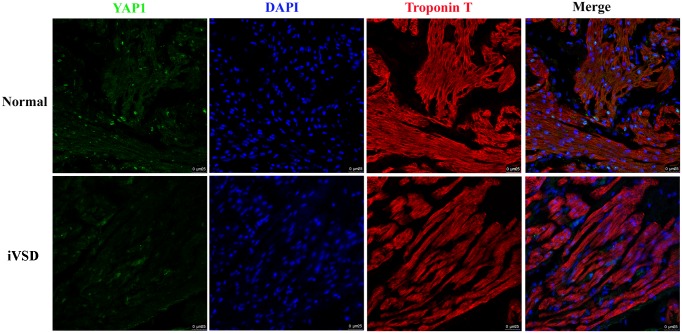
Immunofluorescence revealed that YAP1 expression was significantly lower in iVSD hearts compared to control hearts.Cardiac troponin T (red), YAP1 (green), and DAPI (blue) staining are shown; Scale bar = 25μm.